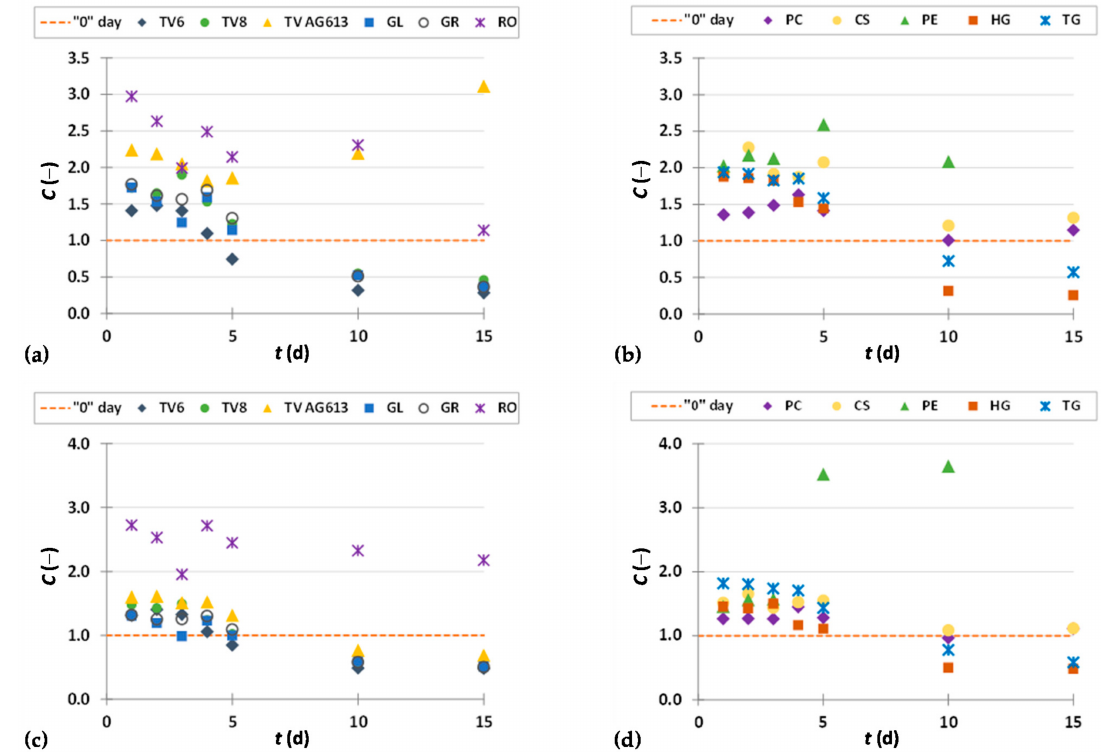
Figure 7. Dimensionless content ( C = C i / C o ) of epicatechin gallate ( a , b ) and gallocatechin gallate ( c , d ) in GP extracts before biological treatment (‘0’ day) and after 1–15 days of biological treatment with TV6, TV8, TV AG613, GL, GR, RO ( a , c ), and PC, CS, PE, HG, TG ( b , d